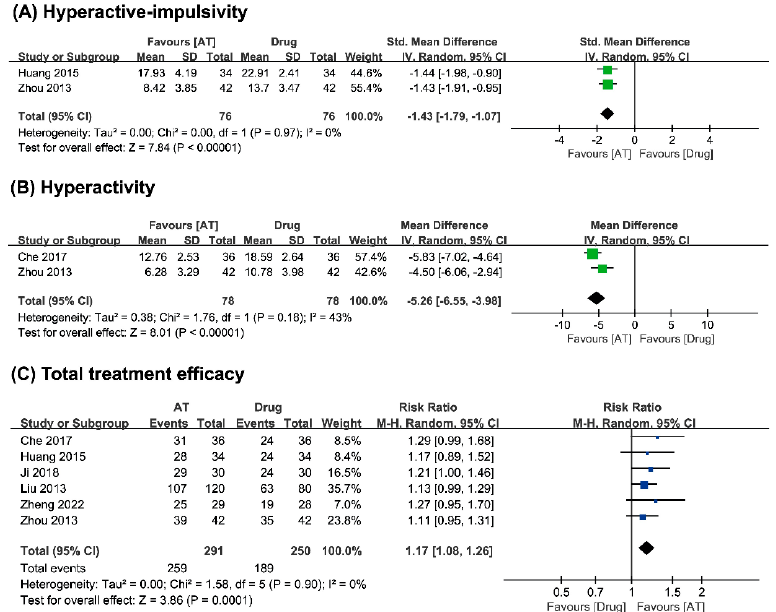
Figure 3. Forest plot of ( A ) hyperactivity–impulsivity, ( B ) hyperactivity, ( C ) total treatment efficacy of acupuncture vs. conventional medicine.